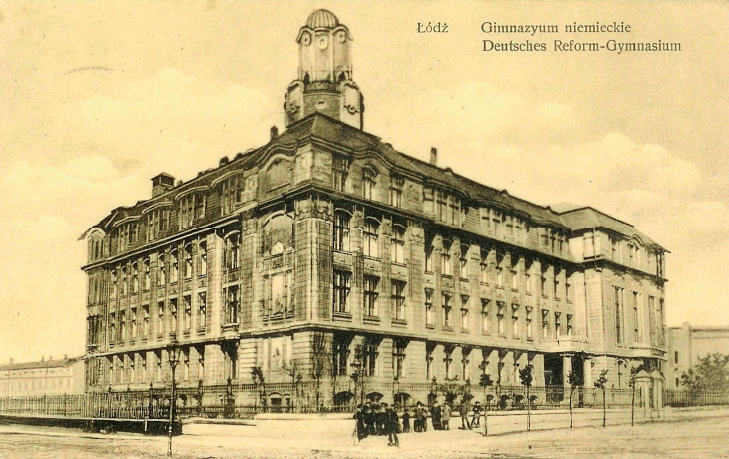
Figure 2. The German Gymnasium, 1908 [15].